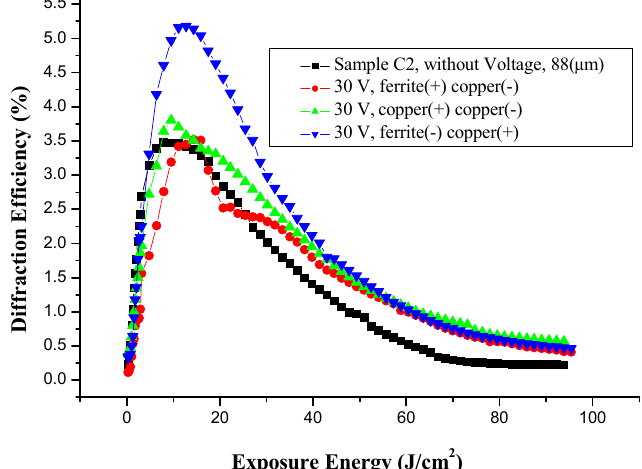
Figure 16. Diffraction efficiency of 30 V voltage with thickness of 88 µm of sample C2 with a frequency of 1132 lines/mm, using different